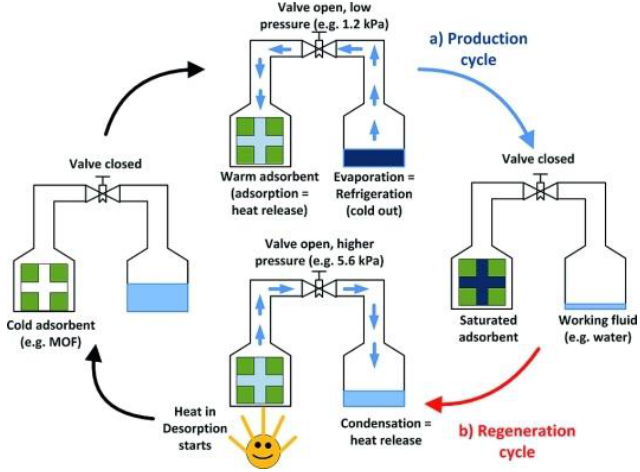
Figure 1. Illustration of the basic principle for adsorption chillers or heat pumps. Reproduced with permission from [18]. Wiley, 2011. MOF, metal–organic framework.